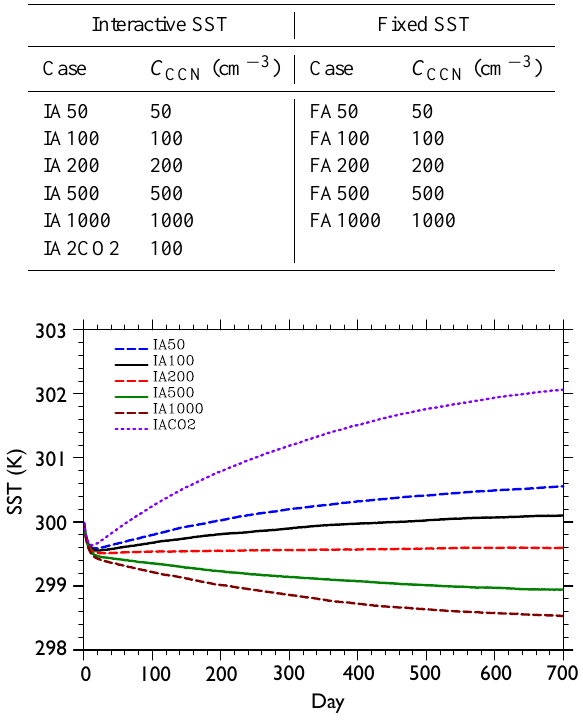
Fig. 1. Time evolution of the SST in interactive-SST